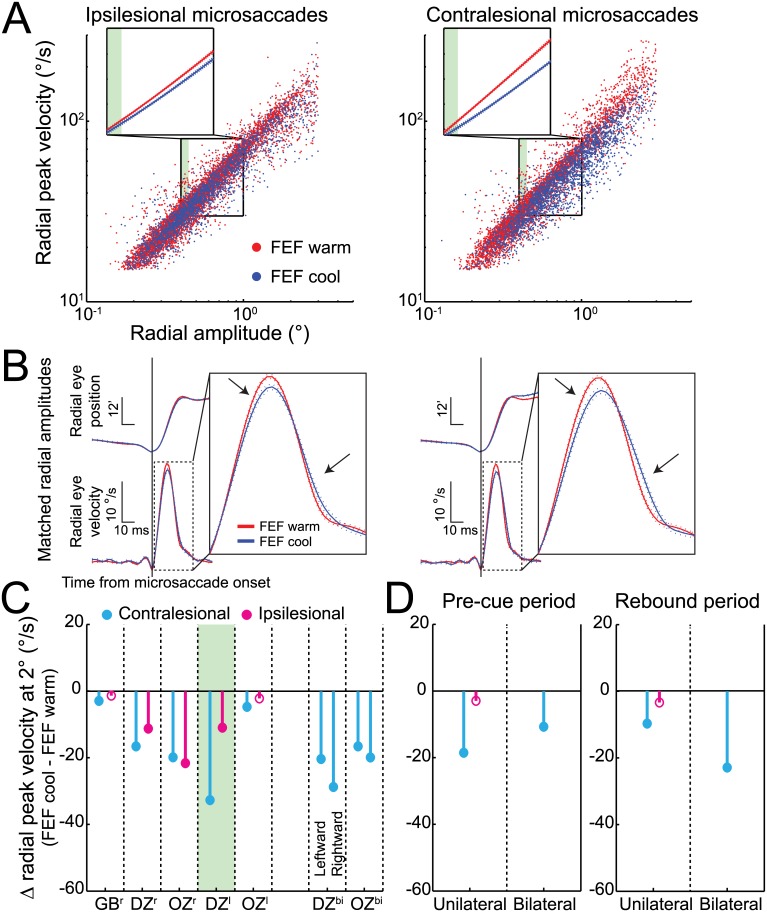
FEF inactivation decreased ipsilesional and contralesional microsaccade peak velocities, both before and after cue onset.(A) Unilateral (left) FEF inactivation reduced peak velocity for contralesional microsaccades independently of amplitude in our example monkey DZ and also decreased peak velocities for ipsilesional microsaccades. As shown in each inset, decreased peak velocities were associated with a downward shift in the main sequence relationship (+/- 95% confidence intervals). (B) FEF inactivation reduced peak velocity for microsaccades matched for radial amplitude, here shown for monkey DZ by averaging radial eye position and velocity traces (+/- standard error) aligned to microsaccade onset. As indicated by the shaded regions in A, we selected ipsilesional and contralesional microsaccades having radial amplitudes between 0.40° and 0.45°. The bilateral influence of FEF inactivation on amplitude-matched microsaccades is demonstrated by decreased peak velocity and increasing duration within the enlarged radial velocity traces (see arrows). (C) Peak velocity extracted at 2° decreased for contralesional microsaccades across monkeys and inactivation configurations and occasionally decreased for ipsilesional microsaccades. Distributions of peak velocities at 2° were obtained by bootstrapping 5,000 random samples of microsaccades and extracting the peak velocity at 2° from each linear regression. (D) Across monkeys, unilateral and bilateral FEF inactivation produced similar decreases in contralesional peak velocity at 2° in both the pre-cue and rebound periods. Filled symbols in C and D indicate statistically significant differences using a Welch's t test (p < 0.05) with 5,000 bootstrapped samples from each of the FEF warm and FEF cool conditions. Data in Supporting Information (see S2 Data).